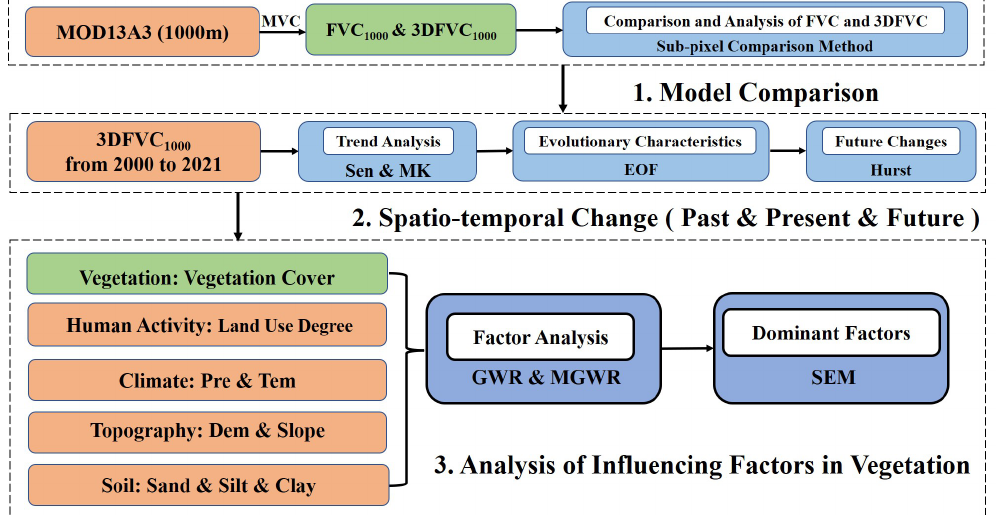
Figure 2. Framework of data processing